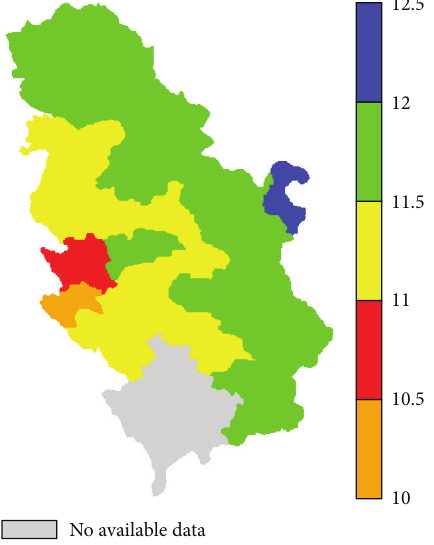
Figure 6: Spatial pattern of the precipitation concentration index.